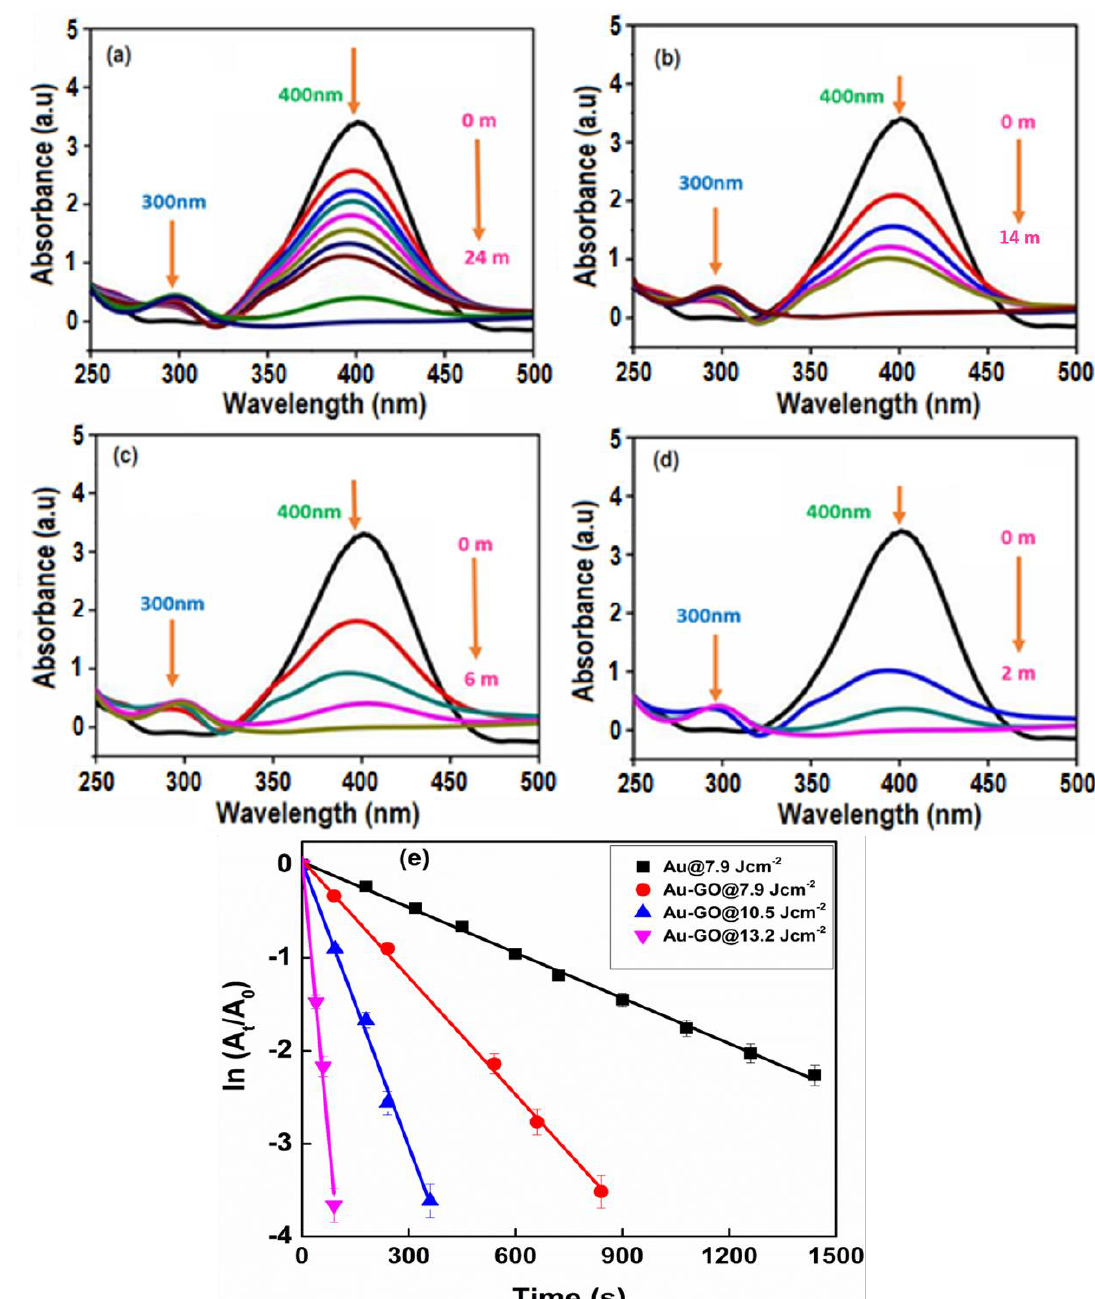
Figure 8. Time-resolved UV-Vis absorption spectra attributed to the catalytic reduction of 4-nitrophenol (4-NP) to 4-aminophenol (4-AP) with ( a ) Au NPs)@7.9 Jcm − 2 ; ( b ) Au-GO@7.9 Jcm − 2 ; ( c ) Au-GO@10.5 Jcm − 2 ; ( d ) Au-GO@13.2 Jcm − 2 ; ( e ) plot of ln( At/A 0 ) against the reaction time of various proportions of the Au-GO samples.